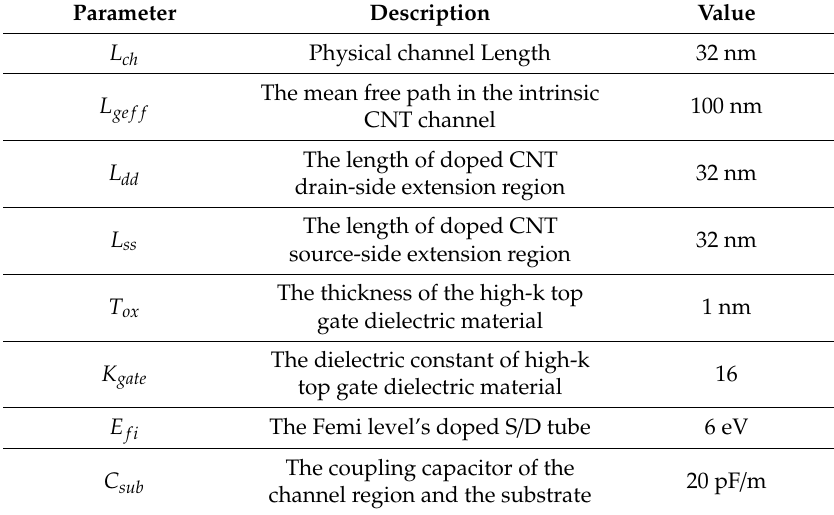
Table 4. Carbon-nanotube field-e ff ect transistor (CNFET) Model